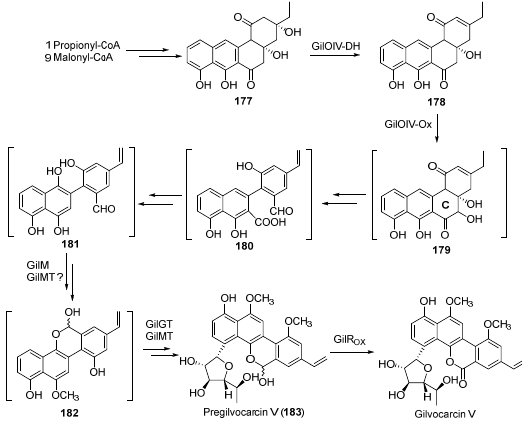
Figure 24. Proposed biosynthetic pathway of gilvocarcin V.